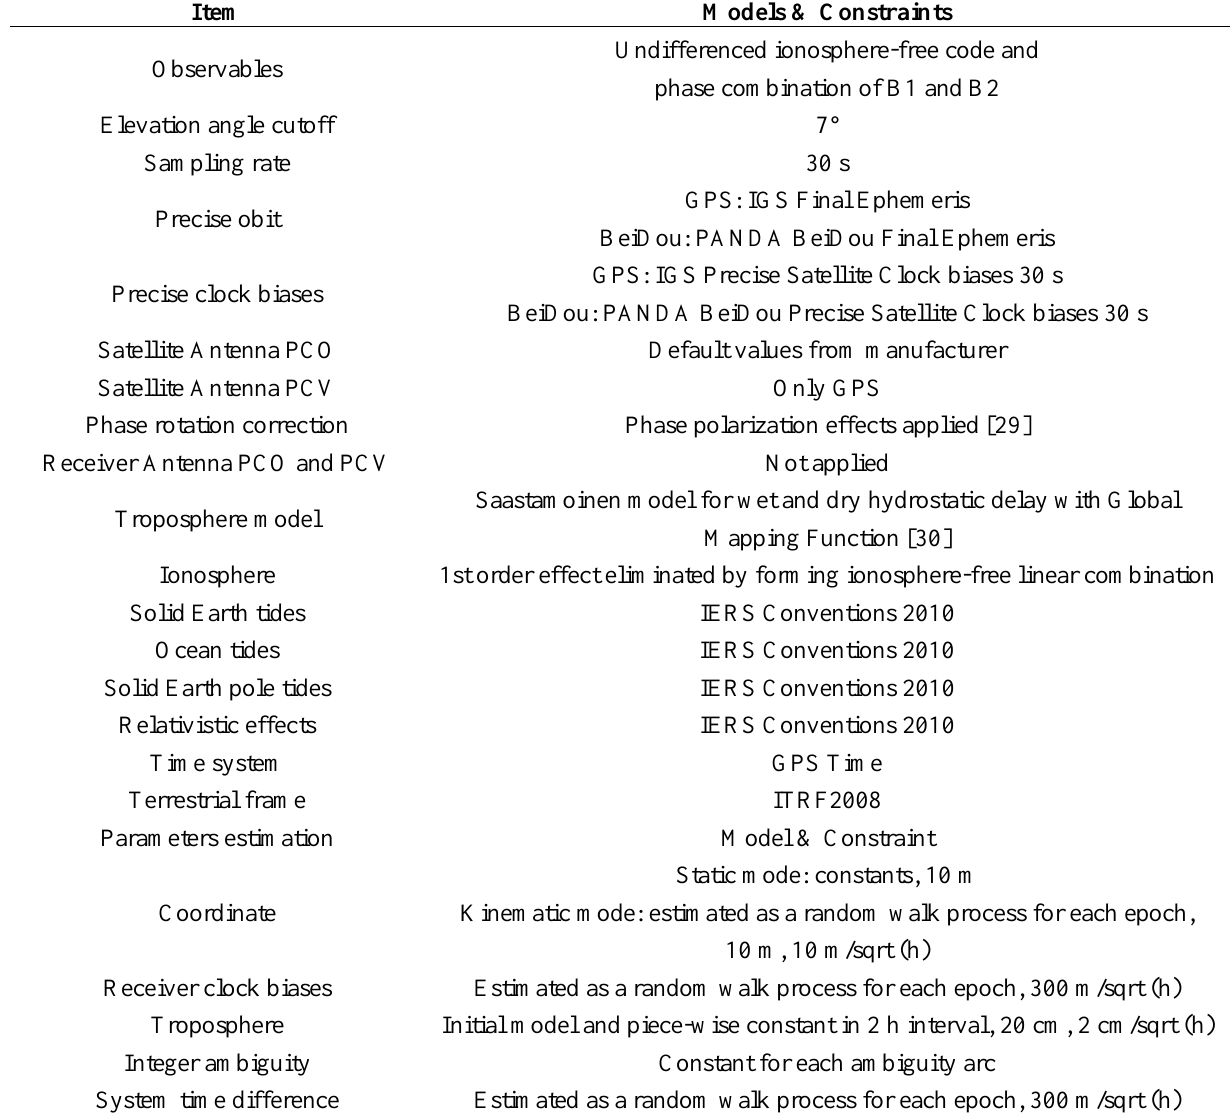
Table 1. The strategies for BeiDou PPP and BeiDou/GPS